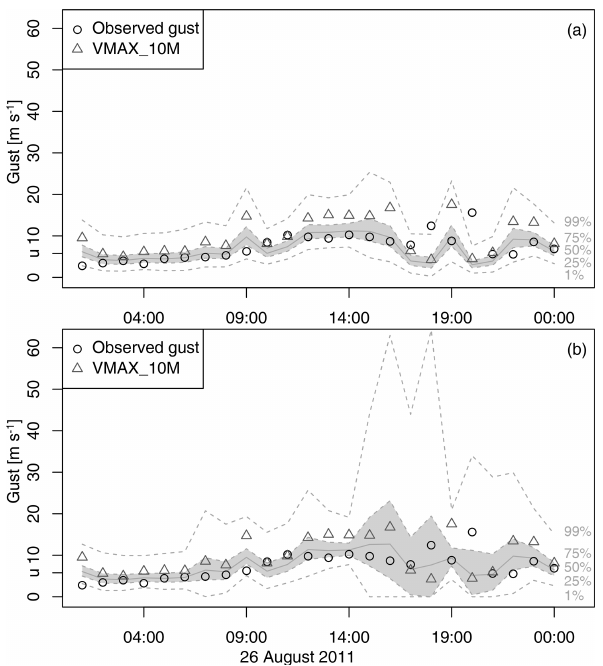
Figure 3. Post-processing of gusts on 26 August 2011 at 10m: (a) Legendre model without VAR t VMAX_10M; (b) Legendre model. Shading indicates the predictive interquartile range, the grey line indicates the median, and dashed lines indicate the 1% and 99% quantiles respectively. The observed gust are shown as circles, and the 10m gust diagnostic is shown as